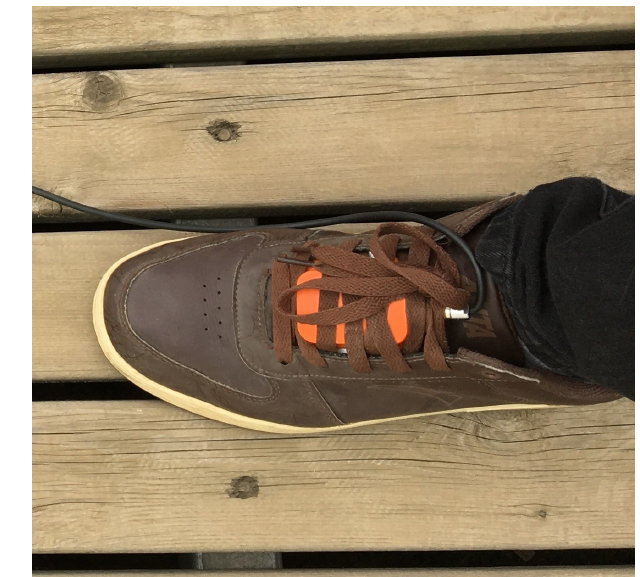
Figure 3. MTi IMU sensor attached to the shoe.